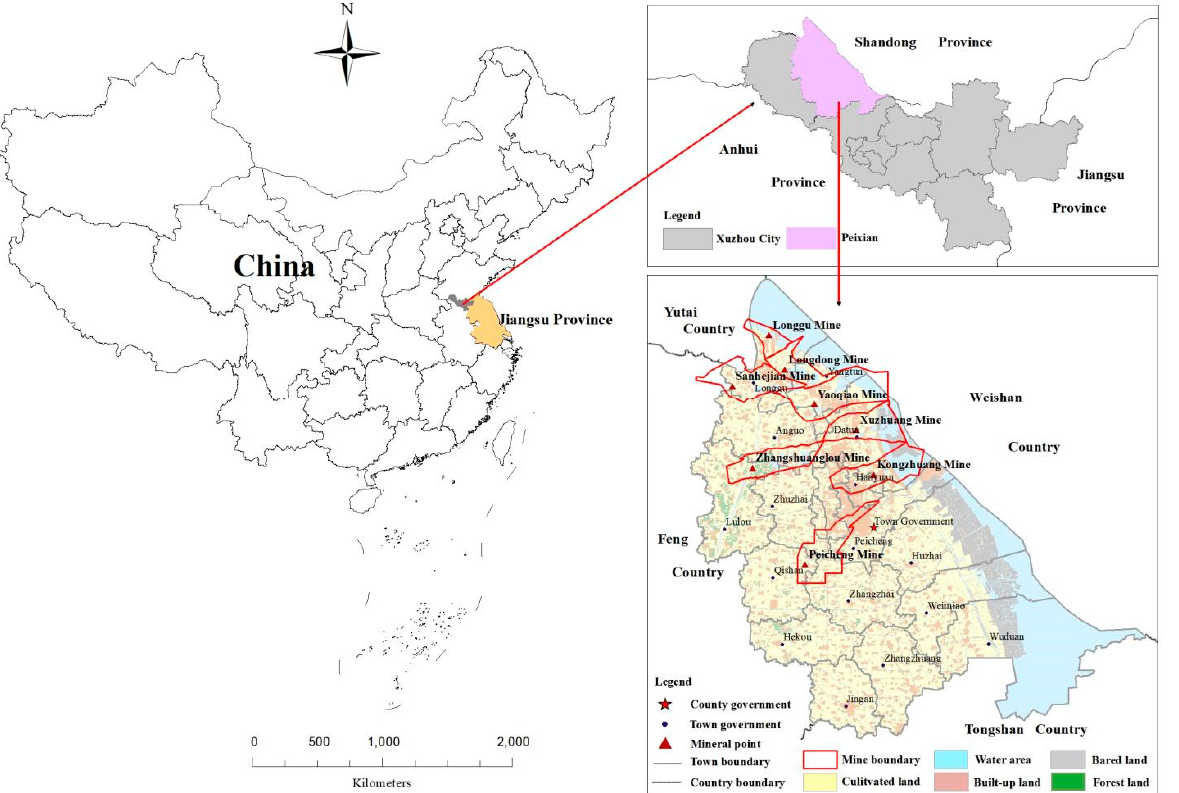
Figure 1. Overview of the study area.